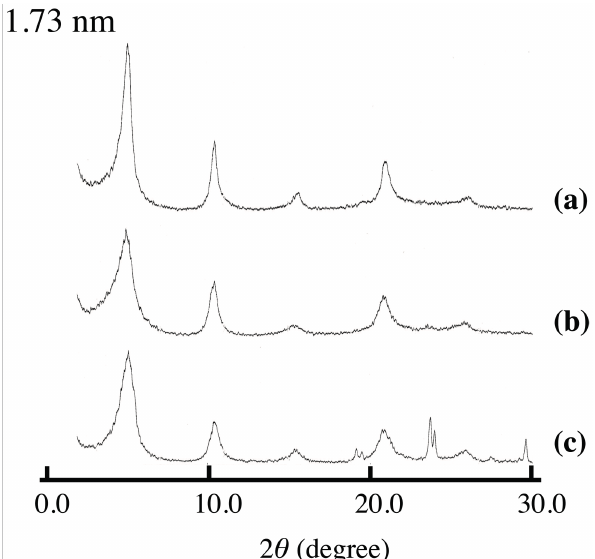
Figure 2. XRD patterns of ( a ) SA-K intercalated LDH(NO solution, and LDH(NO ) ground with 1.3 mmol per 1 g LDH(NO 3 temperature ( b ) after and ( c ) before washing with